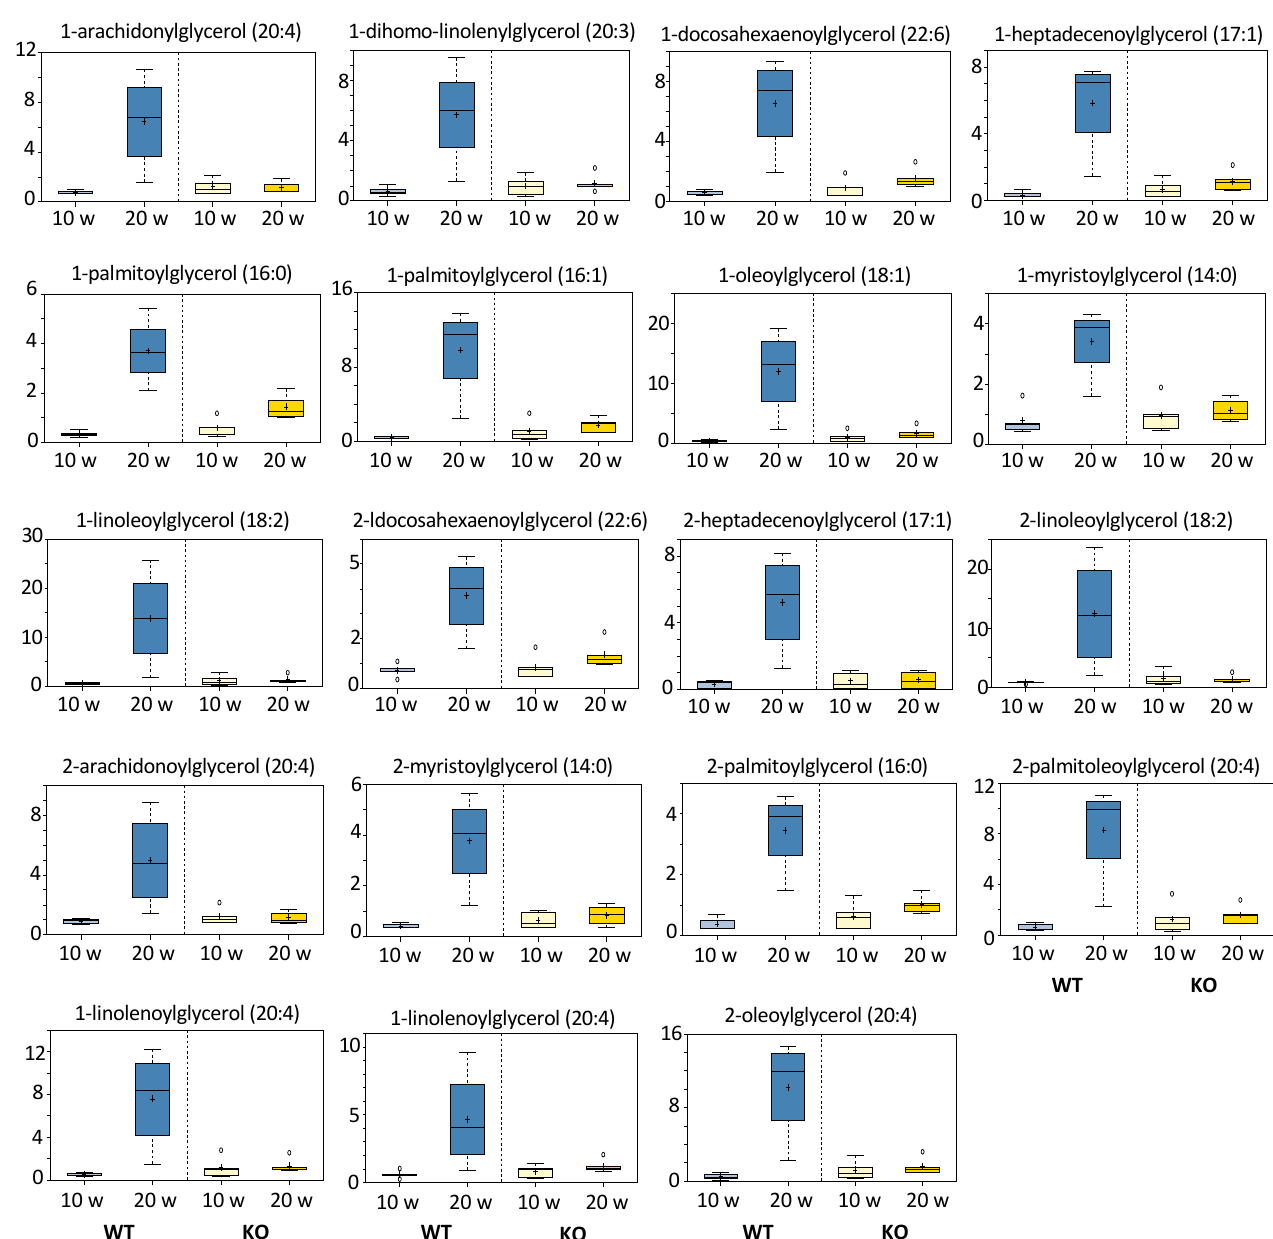
Figure 6. Effect of DEN on monoacylglycerols in the livers of Aldh1l1 +/+ (WT) and Aldh1l1 − / − (KO) mice. Y-axes of individual metabolite box plots represent scaled intensity. Measurements for each biochemical in the original scale were rescaled to set the median equal to 1.